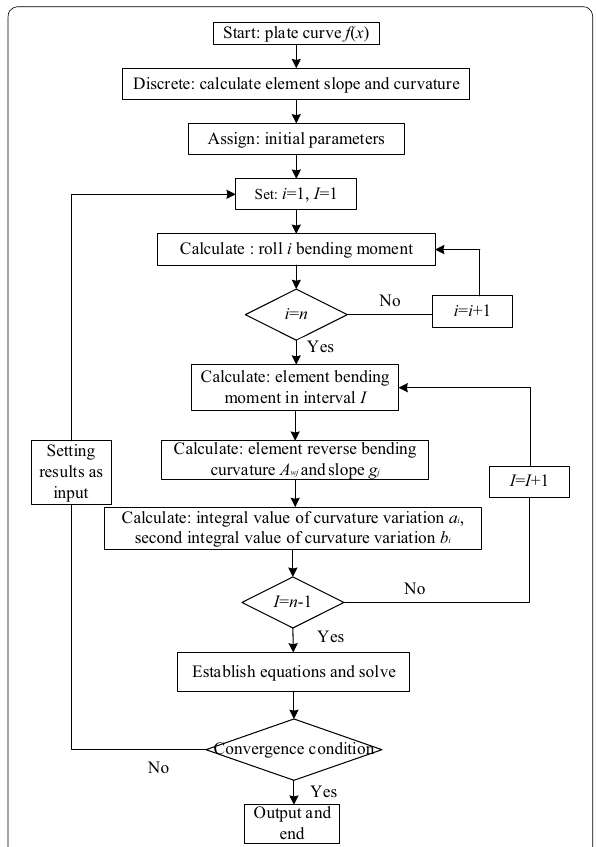
Figure 4 Curvature integration model analysis flow chart in the dynamic leveling